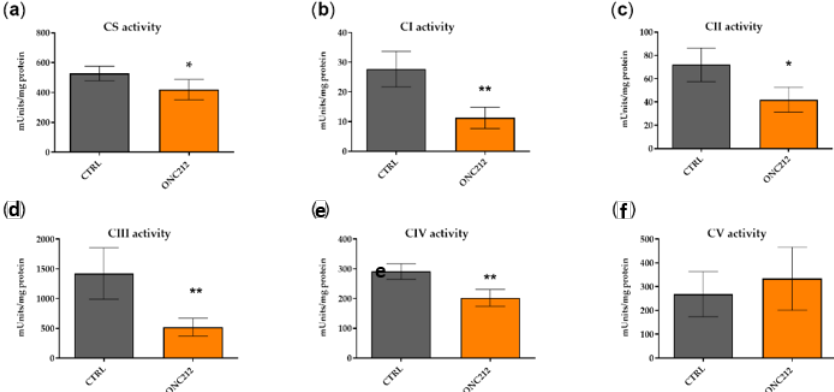
Figure 6. Absolute activities of citrate synthase and OXPHOS complexes in isolated mitochondria from 300 nM ONC212- or vehicle-treated A375 cells. ( a ) Citrate synthase (CS); ( b ) Complex I (CI); ( c ) Complex II (CII); ( d ) Complex III (CIII); ( e ) Complex IV (CIV); ( f ) Complex V (CV). Values are given as mean ± SD. Unpaired T -test; * p ≤ 0.05; ** p ≤ 0.01. The activities of OXPHOS complexes were normalized to protein concentration in cell lysates. Measurements were repeated three times and each measurement includes two replicates (n = 3).